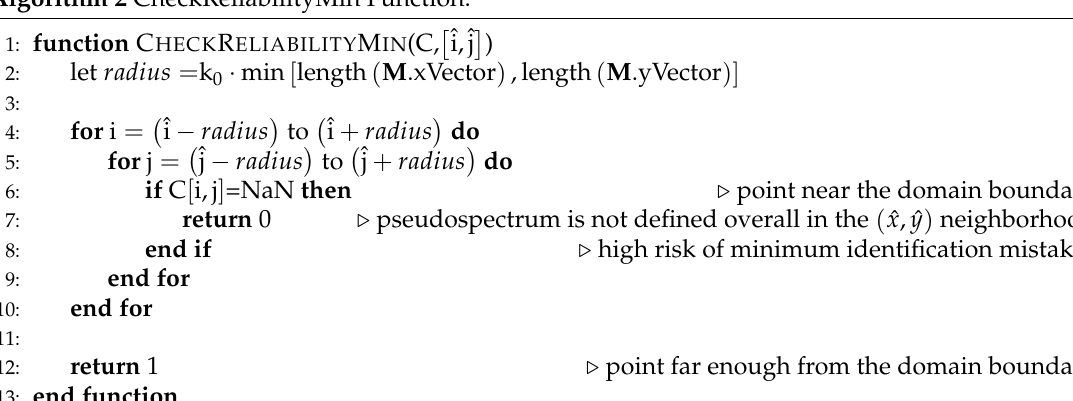
Algorithm 2 CheckReliabilityMin